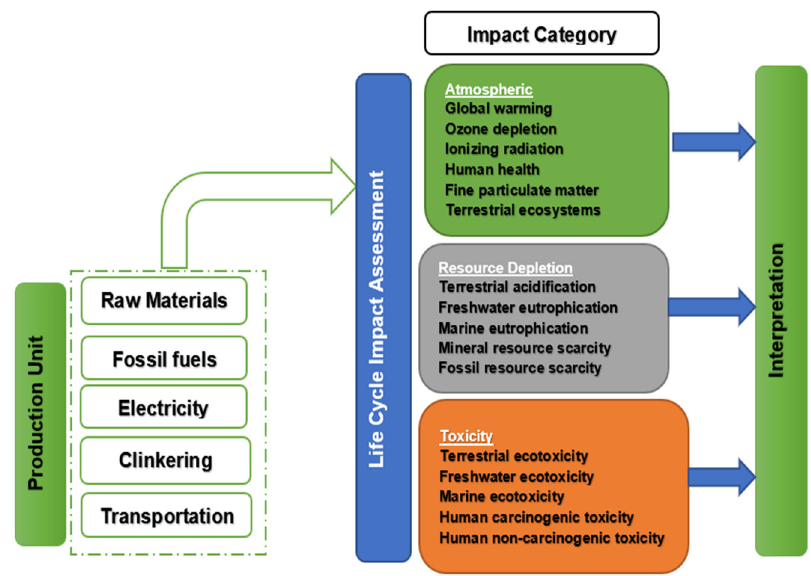
Figure 1. System boundaries of the LCA of Portland cement in South Africa.